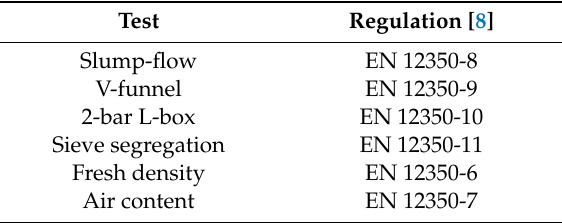
Table 3. In-fresh state tests on each mix.